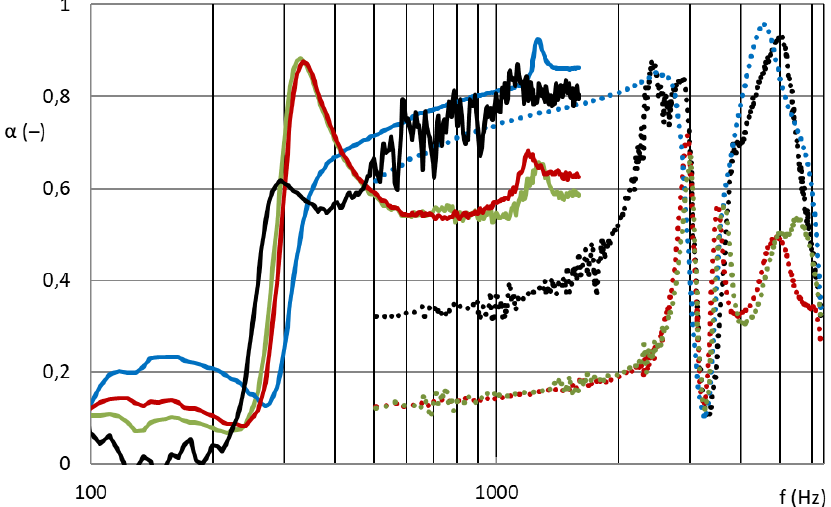
Figure 11. Sound absorption coefficient depending on sound frequency (100 – 6400 Hz). Solid curve: 100 mm diameter samples for frequency range 100 – 1600 Hz; dotted curve: 29 mm diameter samples for frequency range 500 – 6400 Hz. Grid M4 with nanofibrous membrane: blue: PVDF5; black: PA6022; green: PA6022 and PVDF5; red: PVDF5 and PA6022.